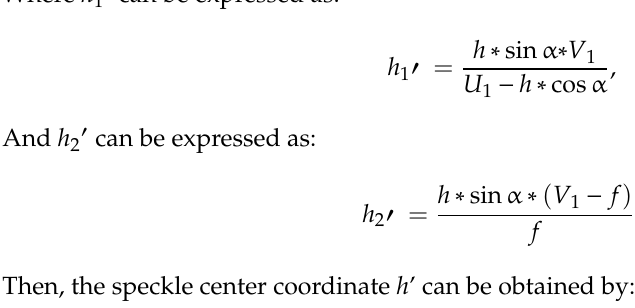
Figure 9. Error analysis schematic diagram.